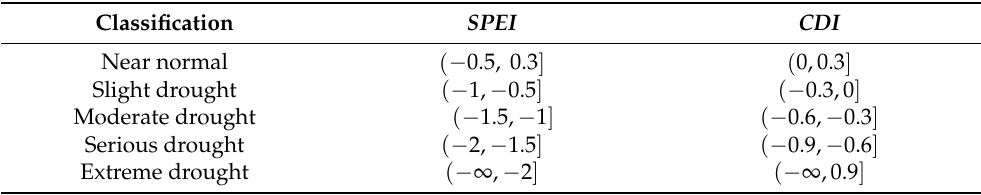
Table 2. Drought classifications of comprehensive drought index ( CDI ) and standardized precipitation evapotranspiration index ( SPEI ).